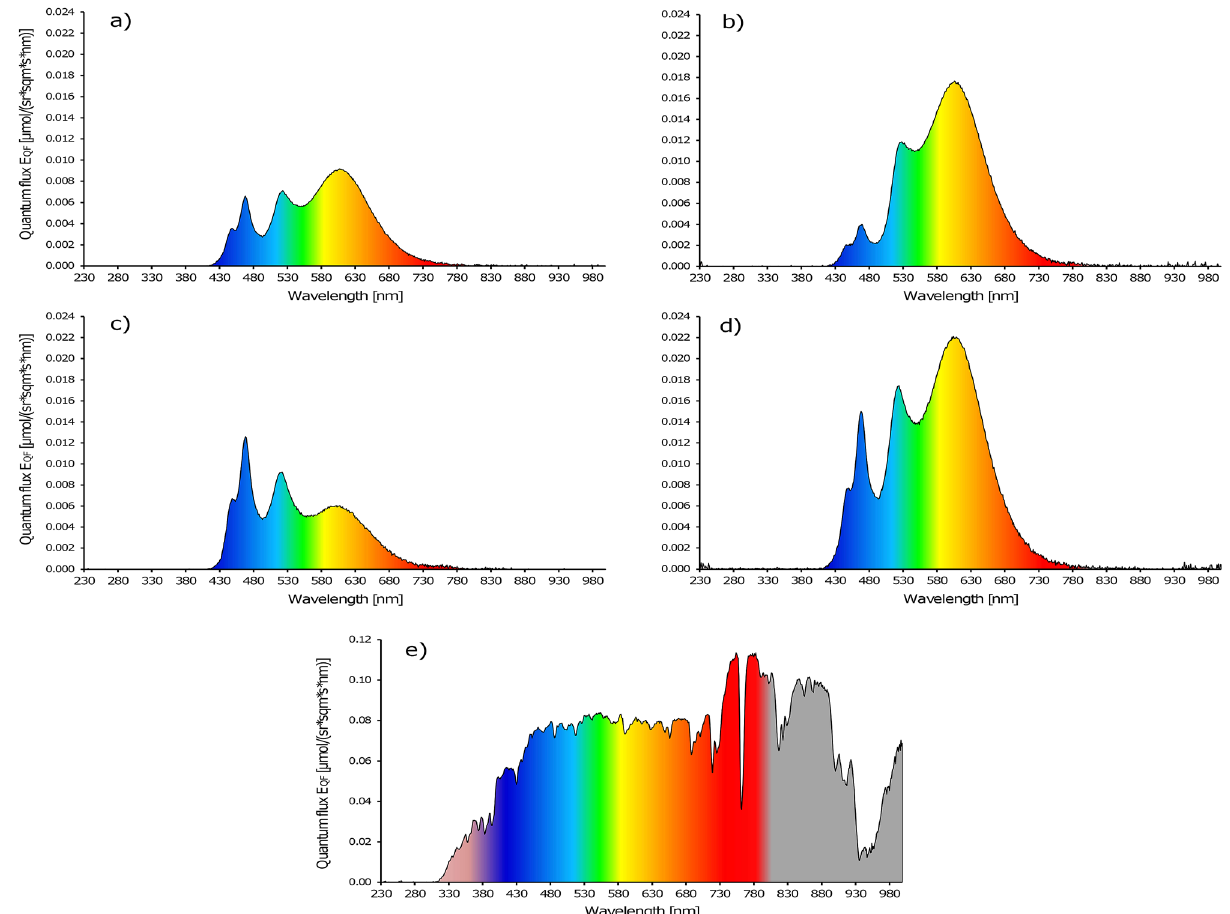
Figure 3. Reflection of light in the wind tunnel ( a – d ) on ( a ) clear plate, ( b ) yellow Horiver plate, ( c ) blue Horiver plate, ( d ) white plate with Stikem glue and in the greenhouse ( e ) measured as reflection on spectralon. Wind tunnel roof light respectively greenhouse sunlight of the thrips visible light (400–635 nm)(measured as spectralon reflection) = 3.64 respectively 17.43 µmol/(sr m 2 s) and white plate reflection = 2.93 µmol/(sr m 2 s). Reflection (%) of the roof light for Stikem respectively D41 on clear plate is 41.2 and 34.2, on yellow plate 65.4 and 59.8, on blue plate 44.1 and 45.3, and white plate 98.9 and plate compared to a D41 glued yellow plate ( P = 0.06). The reflection on the blue plate gave only small changes in light reflection whereby blue increased 4% and yellow decreased 8% of the reflected light on Stikem versus D41. For white plates there was a general increase of 3 to 5% (except violet which is near 100%) of the reflected light in the colour groups and the clear plates gave a general 20% increase of light reflected in all colours. The total brightness of the plates in the visible range increased for Stikem to D41 except for blue which was slightly less bright with Stikem compared to D41 (Fig. 4). Wind tunnel experiments. The results of thrips response in the wind tunnel experiment are shown in Fig. 5. There is a significant effect of the interaction between colour and glue (Table 1, Fig. 4) on thrips catches. The number of western flower thrips was highest on yellow when using clear glue (D41) and significantly differ- ent from the other colours and glue. With diffused glue (Stikem) there was a significant decrease of attraction to yellow (58%) and a significant increase to blue (65%) compared with D41 glue. Significant differences in thrips response (except for clear plates) to the coloured plates with diffused glue were not found. Greenhouse experiments. We found in the rose greenhouse, F. occidentalis on 90% of blue plates and 87% of yellow plates. In the chrysanthemum greenhouse, F. occidentalis was found on 77% of blue plates and 91% of yellow plates. Analysis was performed on the corrected data for western flower thrips and shown in Fig. 6. In both greenhouses, we found a significant effect of the interaction between colour and glue (Table 1). In both crops there was a significant decrease in catch from yellow (35%) and increase to blue (32%) when using Stikem glue compared to D41 glue. Overall, with Stikem glue there was a preference to blue over yellow and with D41 glue a preference of yellow over blue. The light reflection in both greenhouses was similar whereby the glass of the greenhouses blocked approximately 90% of the UV-B and approximately 10% of the UV-A 37 . Other colours entered the greenhouse similar to the outside levels.